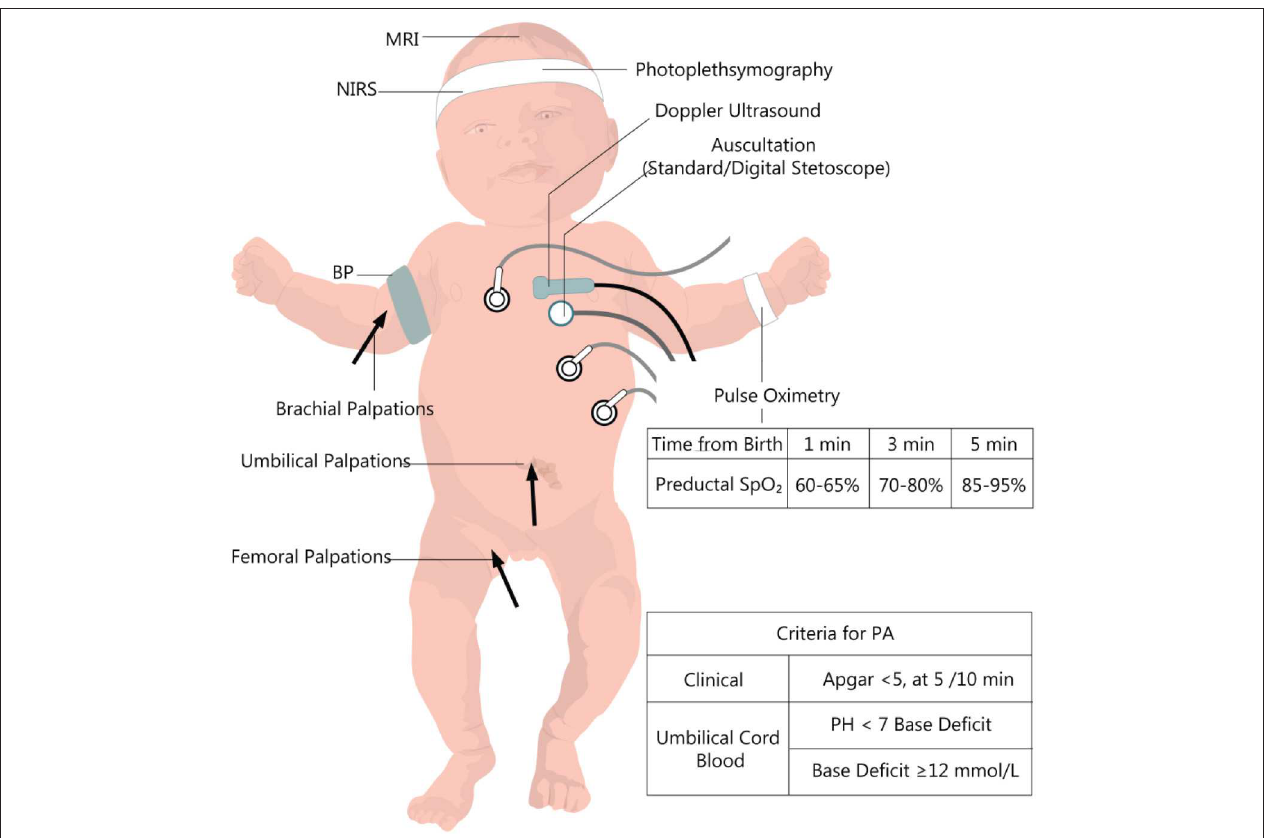
FIGURE 1 | Clinical and paraclinical evaluation of the newborn with perinatal asphyxia. PA, perinatal asphyxia, BP, Blood pressure; NIRS, near-infrared spectrophotometry. Data from the European and American guideline recommendations for time-dependent preductal SpO 2 ( 20,